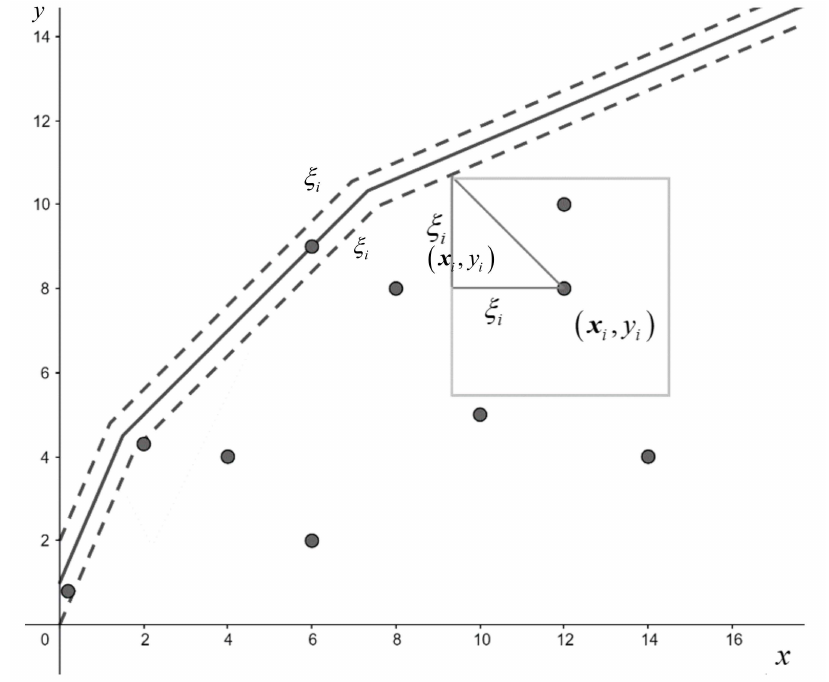
Figure 3. Illustration of the DEAM estimation of a production